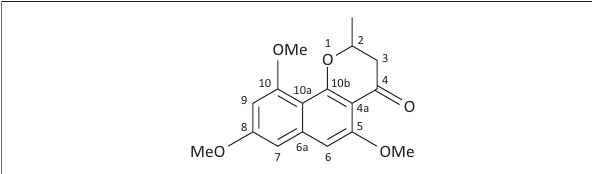
FIGURE 1: Chemical structure of 5-methyldihydroflavasperone.